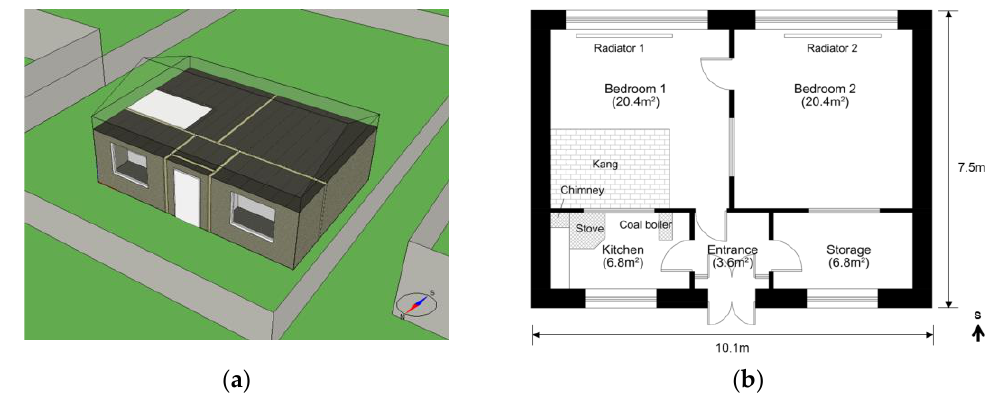
Figure 2. ( a ) Main geometry and ( b ) floor layout of the case building. Table 1. Construction details and thermal transmittance of original envelope and the current require- ments from the standard for newly built rural